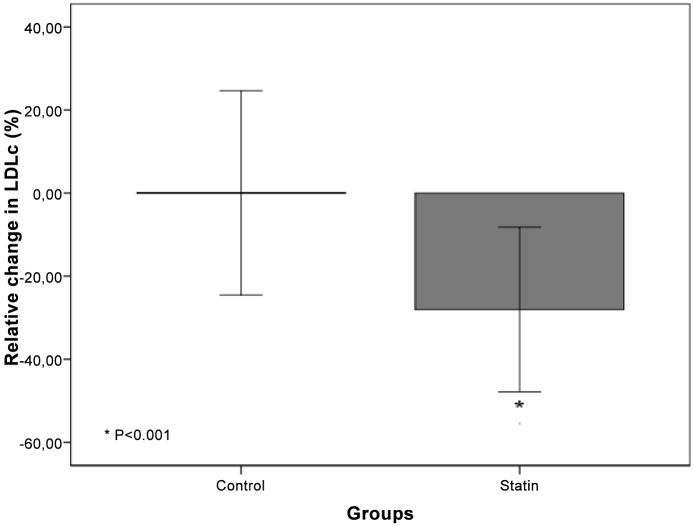
Relative Changes in LDL cholesterol.